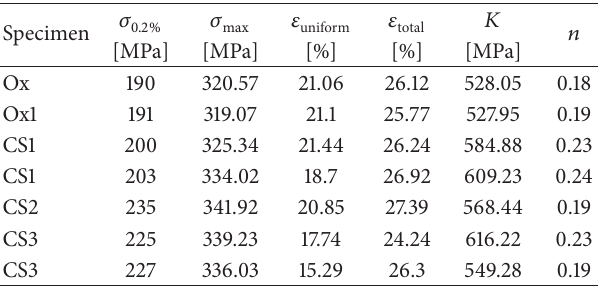
Table 3: Numerical results of uniaxial